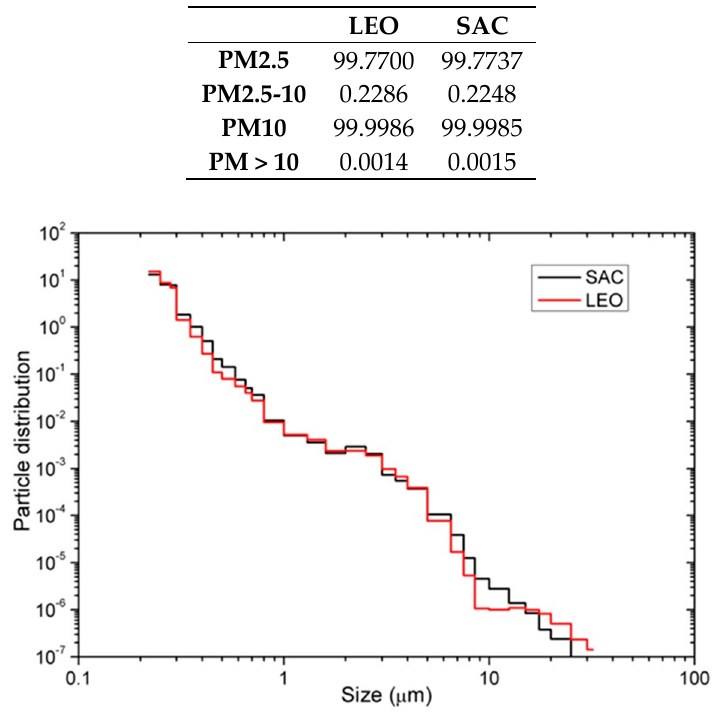
Figure 2. Normalized mean mass concentration distribution for SAC site (black line) and LEO site (red line). Table 2. Percentages (%) of the total mean particle concentration for the fractions PM2.5, PM2.5-10, PM10 and PM > 10.